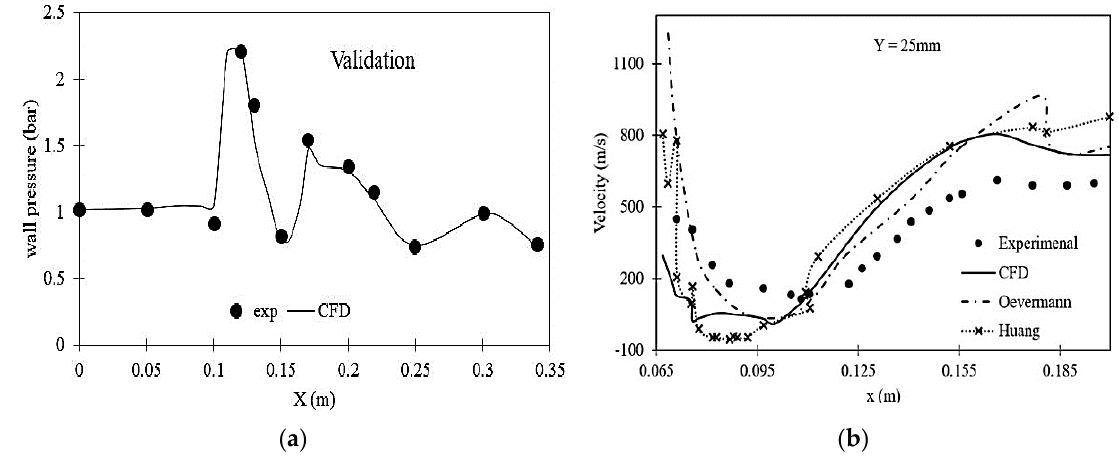
Figure 4. ( a ) Wall static pressure and ( b ) centerline velocity distribution for DLR strut injection of experimental and numerical results.